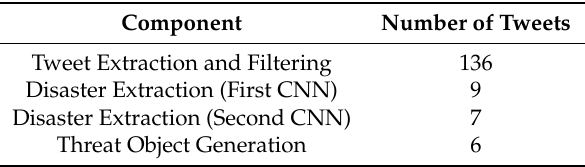
Table 3. Information filtering throughout the